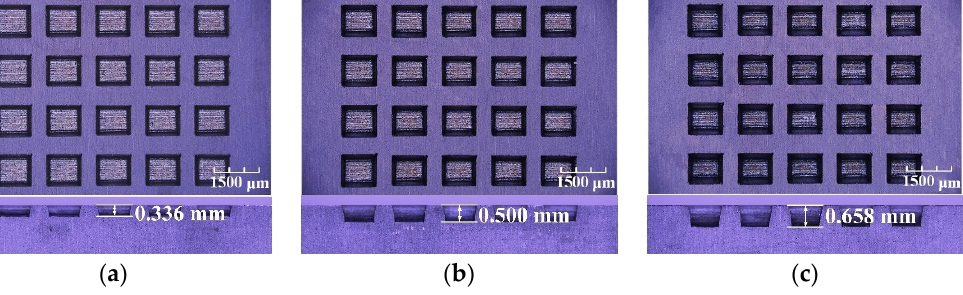
Figure 12. Surface and cross-section of array grooves of 1 mm × 1 mm processed with different times by blowing-assisted laser processing. ( a ) 100 times, ( b ) 150 times, ( c ) 200 times.